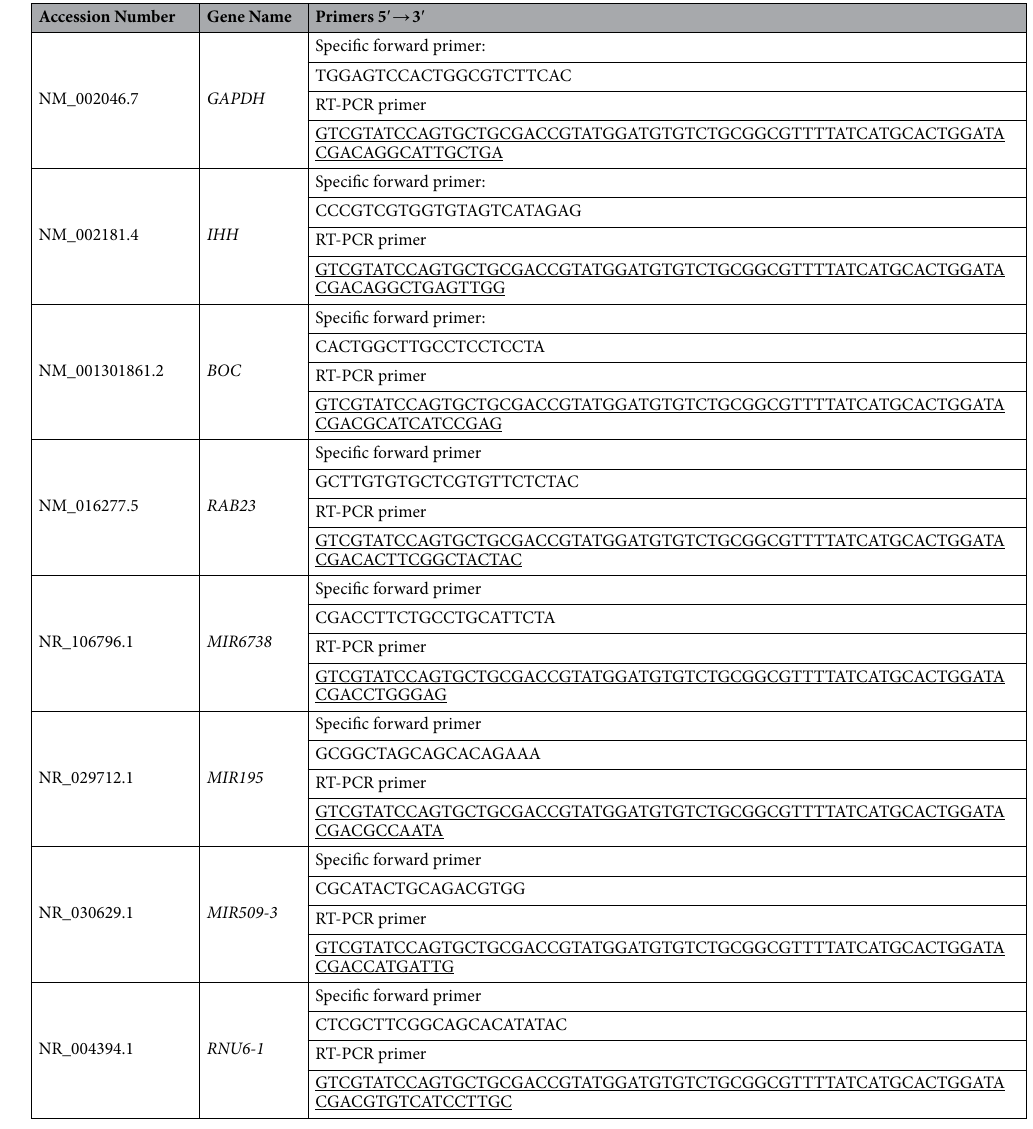
Table 1. Sequences of primers used for evaluation of SHH signaling genes and their regulatory microRNAs. The target specific portion of mRNA and micro-RNA is showed in red bold. Stem-loop sequence is underlined. Tm of the micro-RNA forward primer was increased by adding a tail (green sequences) to the 5 ′ -end of the